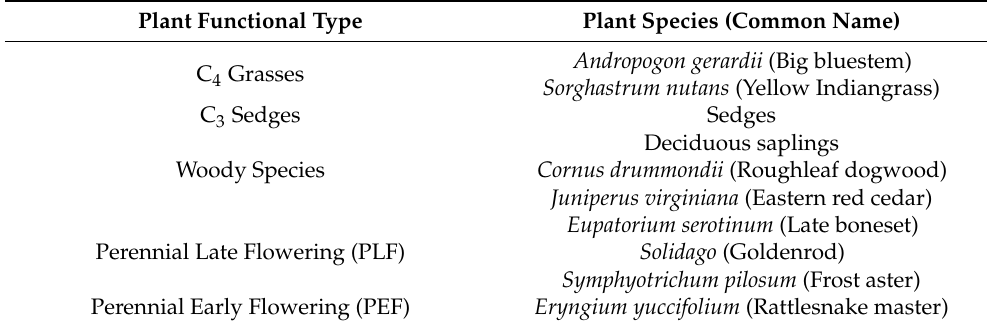
Table 1. Plant species and plant functional types considered in this study adapted with permission from Piper et al. [34]. Note: sedges and deciduous saplings were not identified to species. Plant Functional Type Plant Species (Common Name) C 4